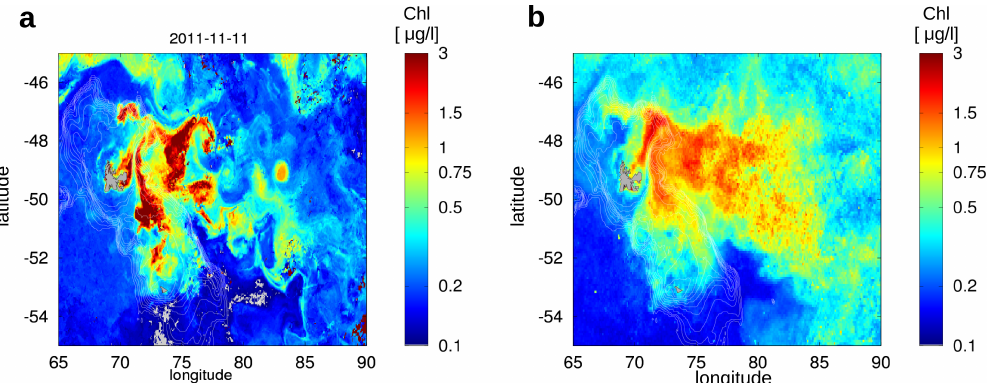
Figure 4. Satellite chlorophyll maps: (a) a snapshot of the situation during the cruise (10 days composite centered on 11 November 2011); (b) November climatology